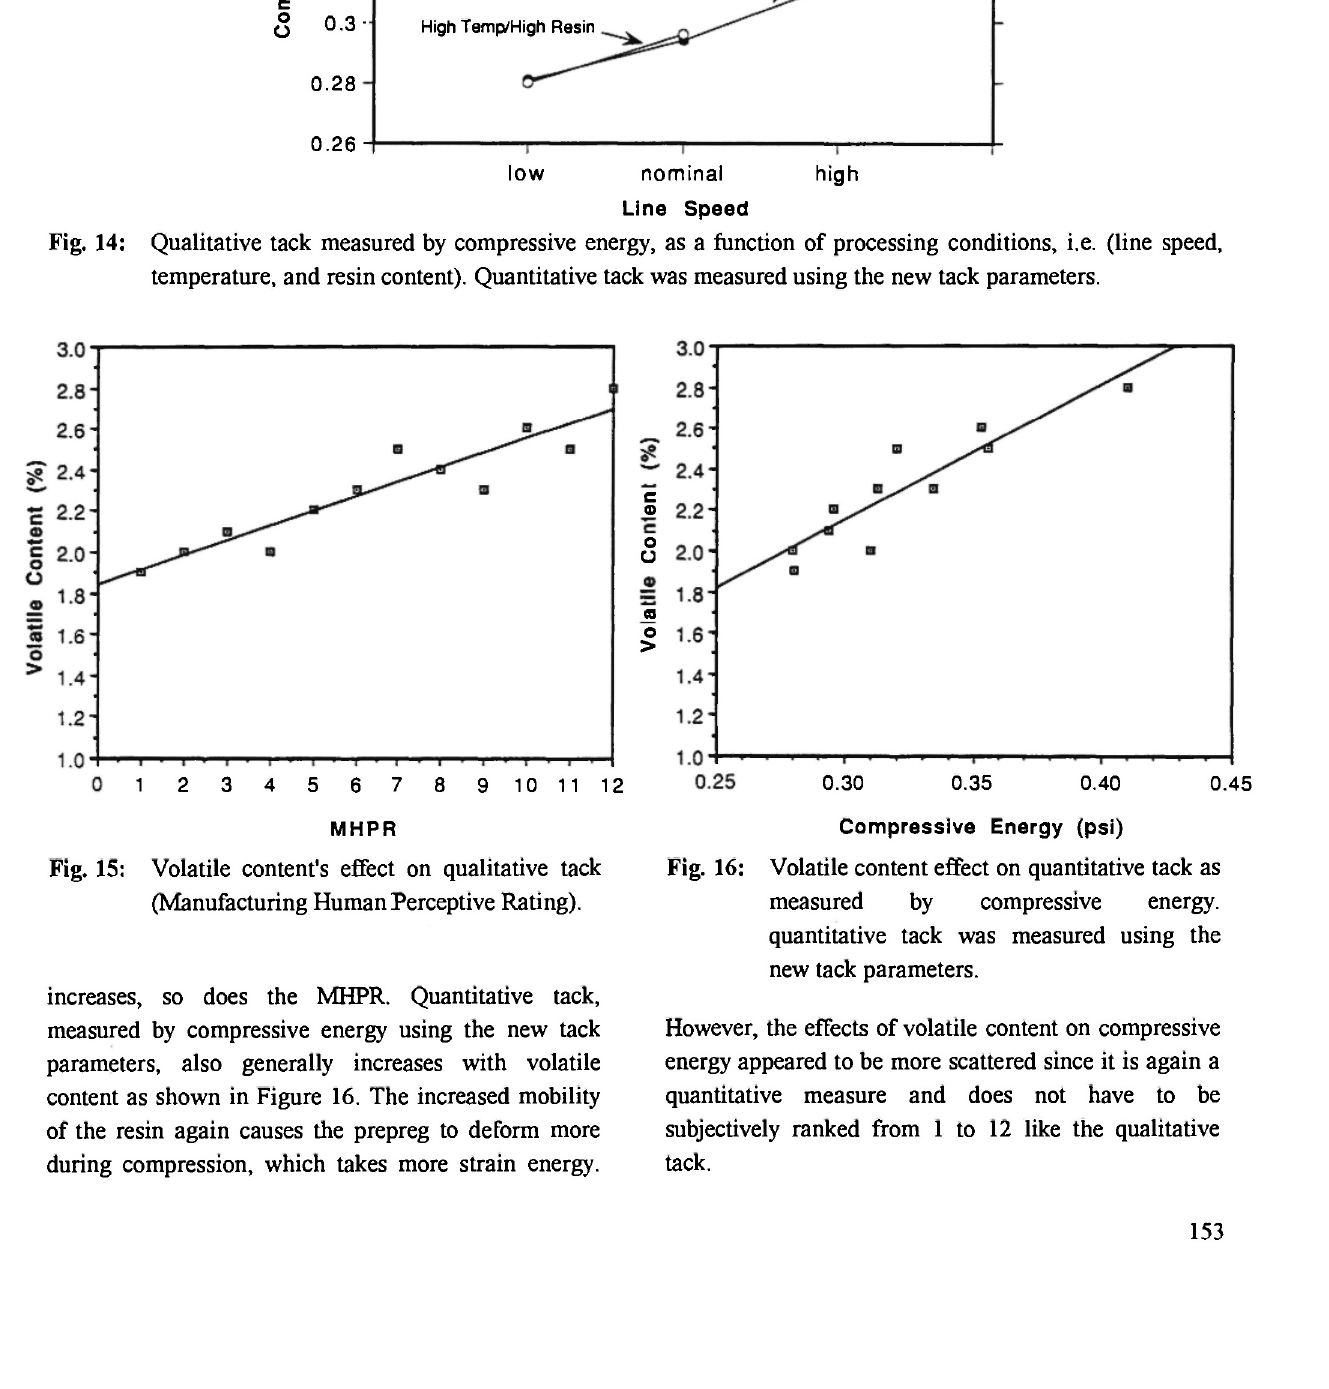
Fig. 16: Volatile content effect on quantitative tack as measured by compressive energy, quantitative tack was measured using the new tack parameters. However, the effects of volatile content on compressive energy appeared to be more scattered since it is again a quantitative measure and does not have to be subjectively ranked from 1 to 12 like the qualitative